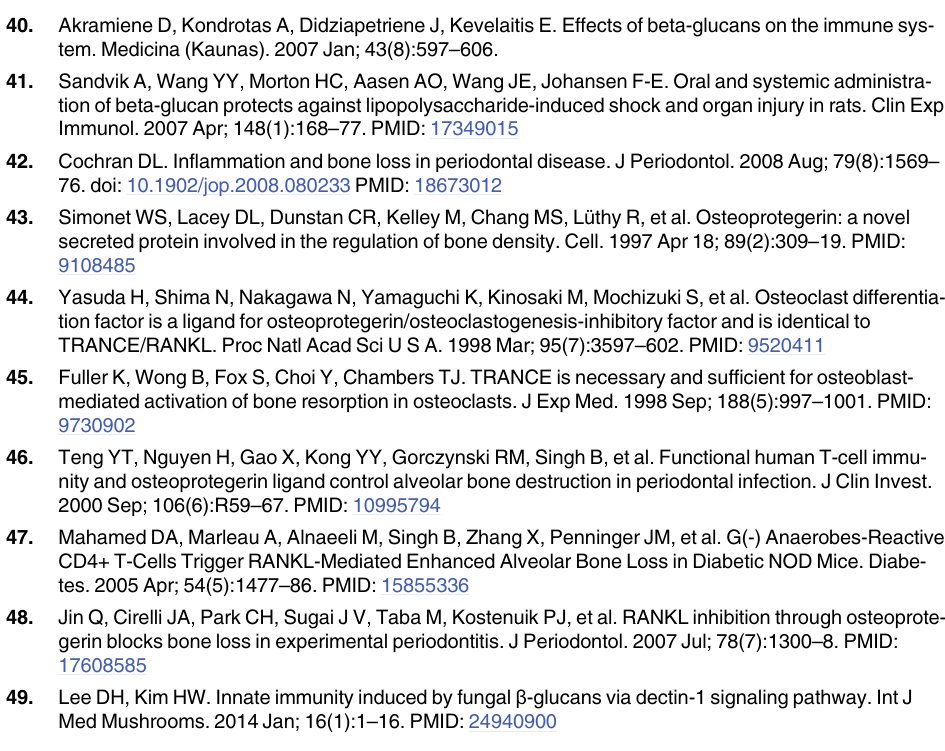
PLOS ONE | DOI:10.1371/journal.pone.0134742 August 20,